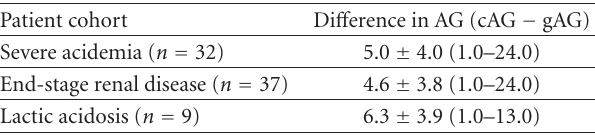
Table 3: Di ff erences in anion gap (AG) between the two analyzers for samples from patients with severe acidemia, end-stage renal disease, and lactic